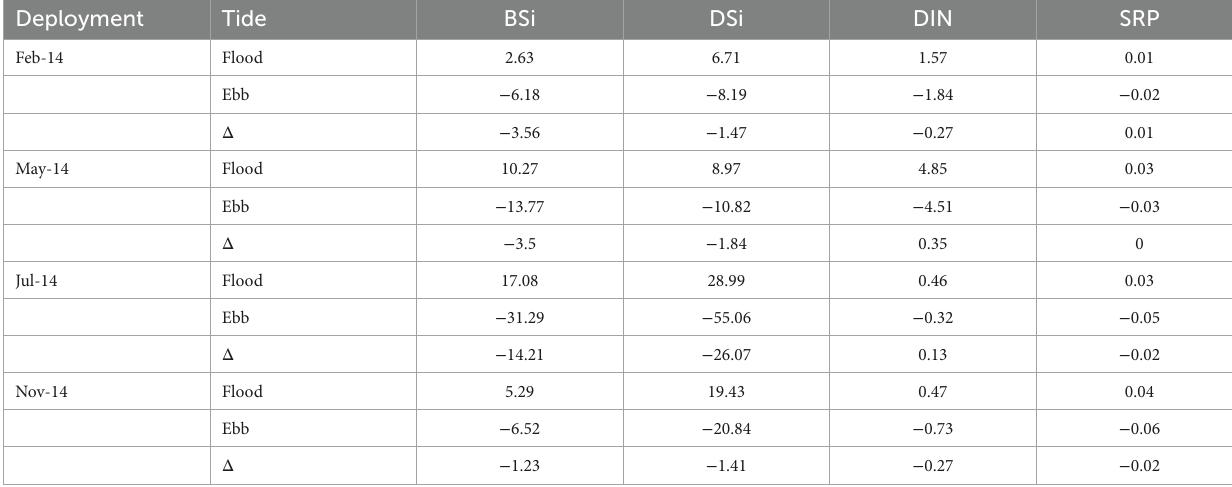
TABLE 2 Mean ( n = 2 tidal cycles) tidal prism and flood and ebb tide concentrations of water column dissolved Si (DSi), biogenic Si (BSi), dissolved inorganic nitrogen (DIN) and soluble reactive phosphorus (SRP), total suspended solids (TSS) and chlorophyll a (Chl a ) at the Cell 1B inlet, Poplar Island, Chesapeake Bay in 2014.